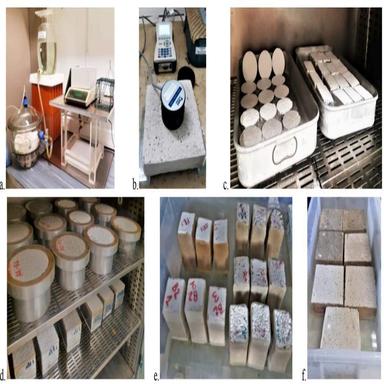
Experimental campaign: apparatus for testing open porosity (a), thermal properties (b), sorption isotherm (c), water vapour permeability (d) and capillary water absorption (e, f).